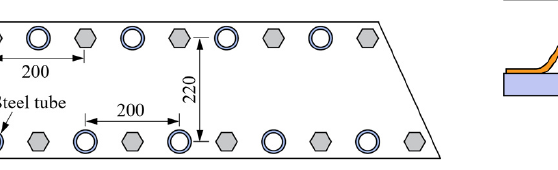
Figure 6. Structural parameters of the end-plate joint.